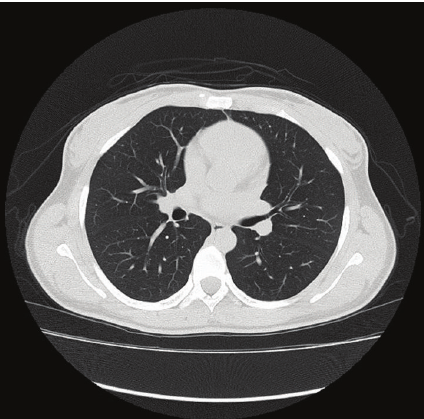
Figure 4: Contrast-enhanced computed tomography on 1-month follow-up demonstrating complete resolution of the parenchymal